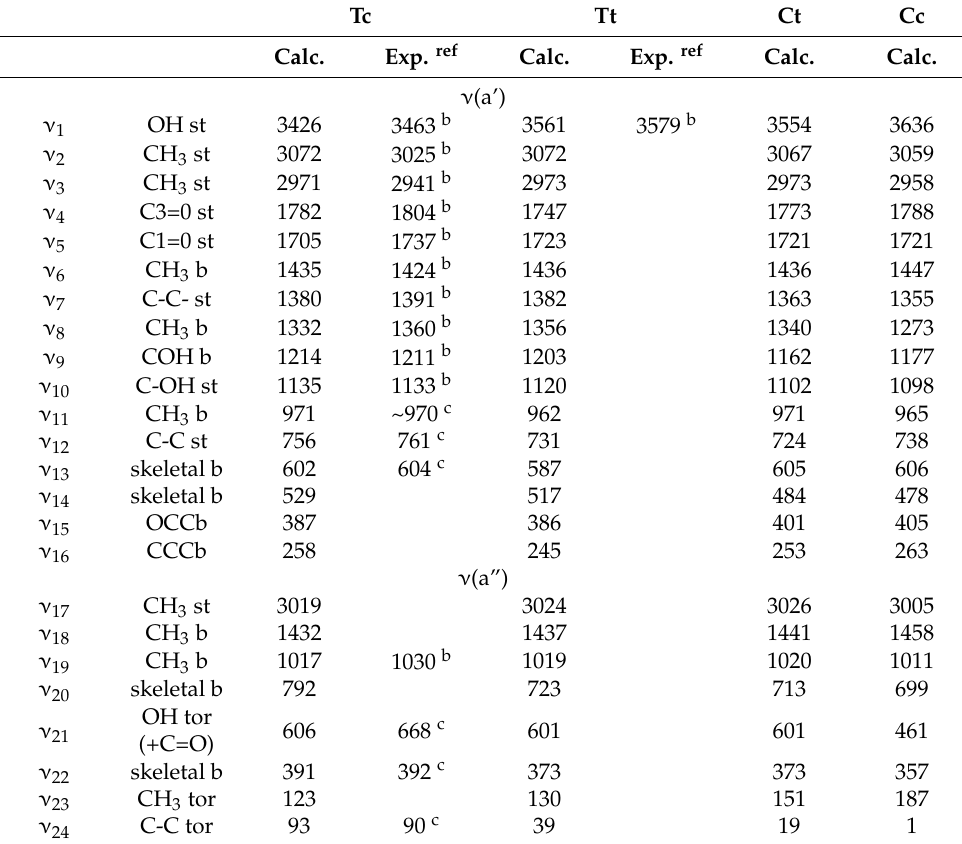
Table 3. MP2/AVTZ anharmonic fundamentals a (in cm − 1